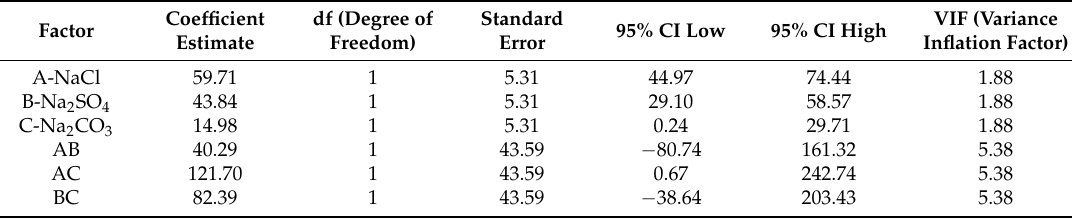
Table 5. The confidence degree analysis of the special cubic